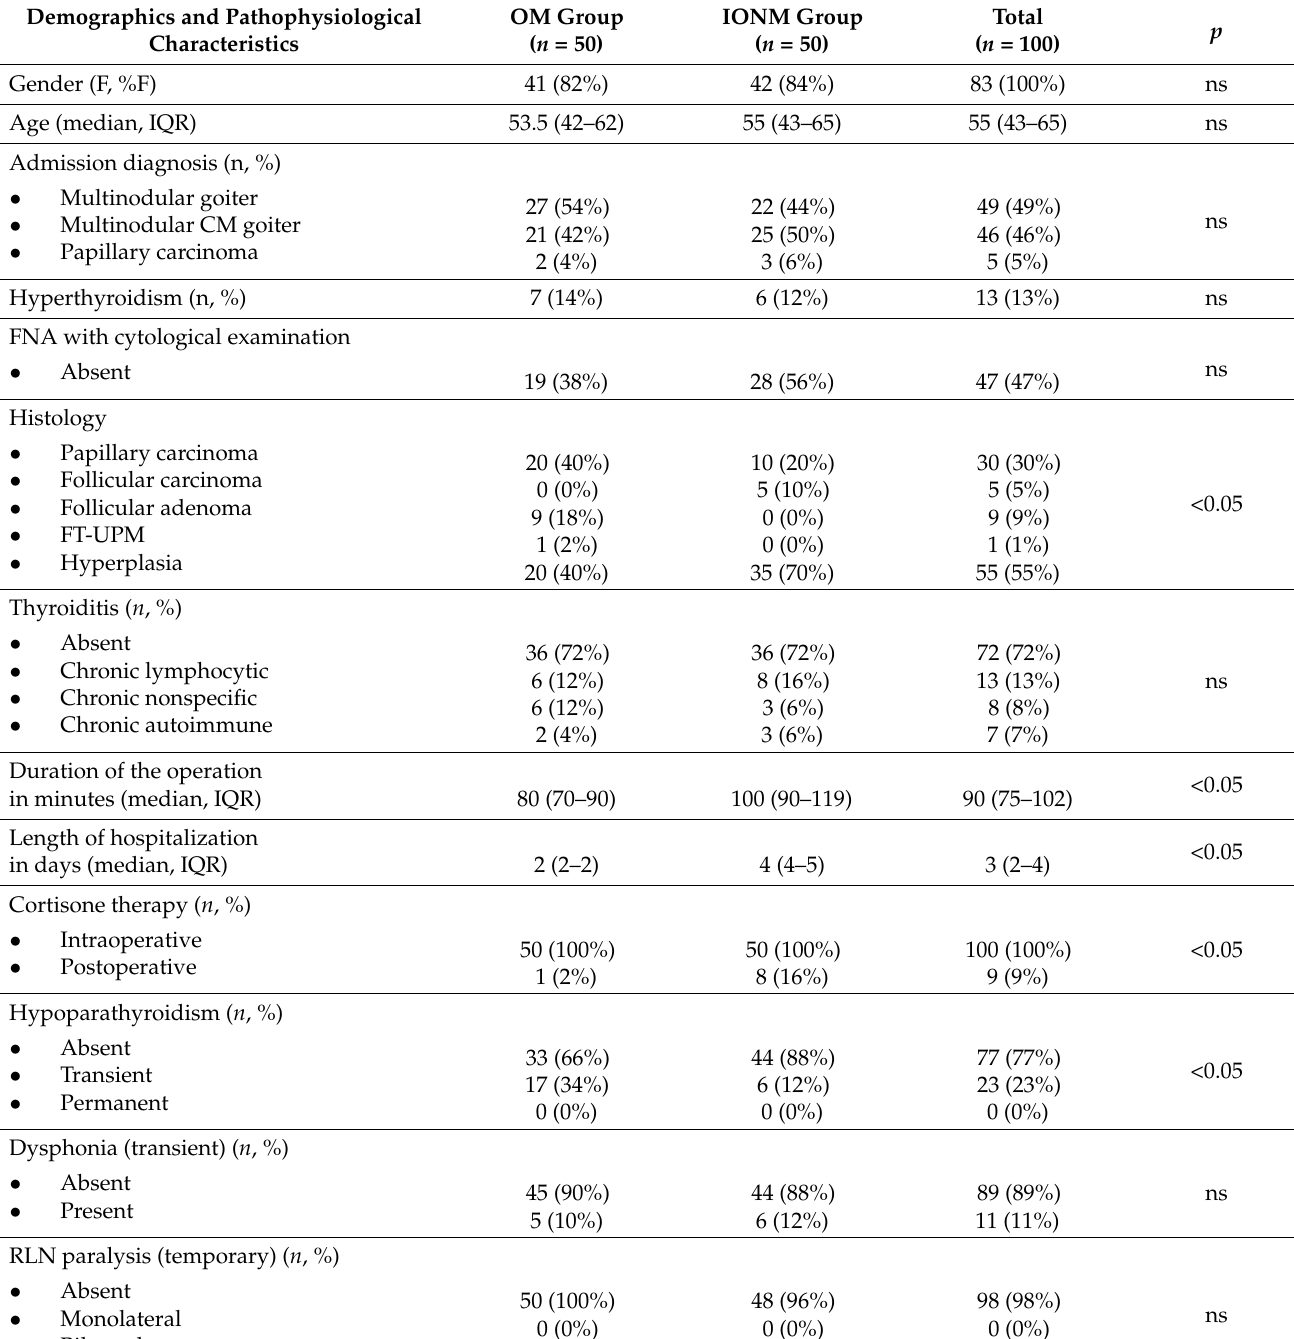
Table 1. The comparison between the OM and IONM group demonstrated statistically relevant data regarding the duration of the operation, transient hypoparathyroidism, and length of hospitalization. Demographics, pathophysiological characteristics, and results in the two groups. Abbreviations: IQR—interquartile range, CM—cervicomediastinal, F—female, FT-UPM—follicular tumor of uncer- tain malignant potential, p -value, ns—non statistically